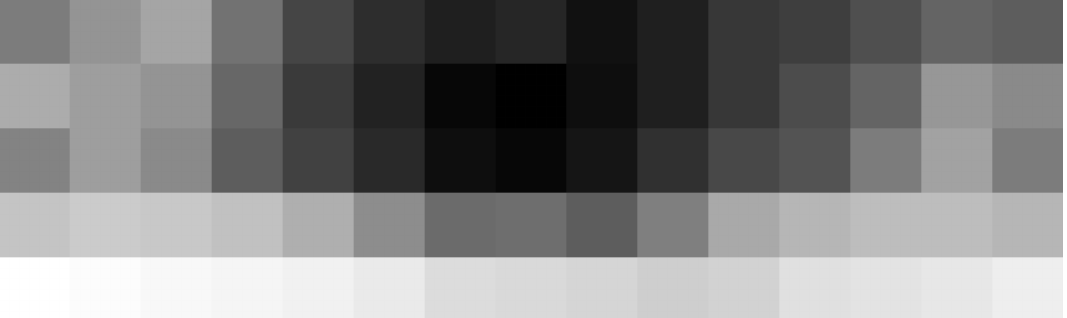
Figure 9. Distribution of reprojection error. Lower values correspond to darker colors. The error increases in all directions from the minimum, which is close to the image